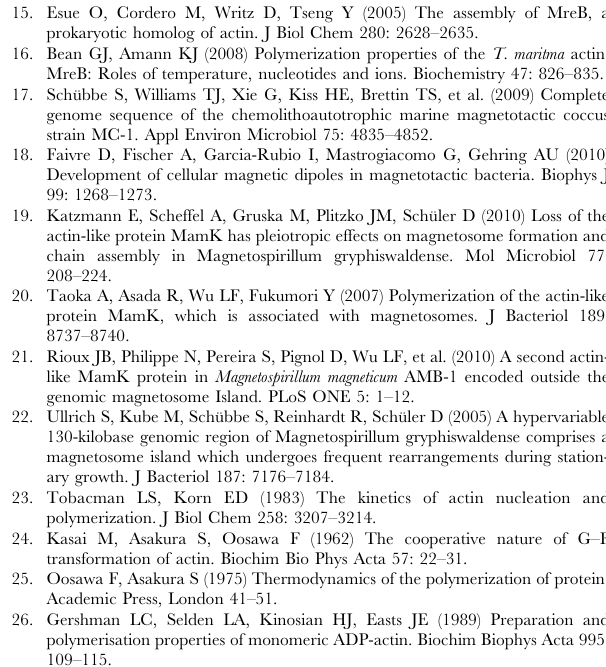
Figure S1 Concentration dependent elution of over- expressed MamK with increasing imidazole. (a) Sodium dodecyl sulfphate-polyacrylamide gel (12%) electrophoresis of purified histidine-tagged MamK eluted using an imidazole gradient to reduce the co-purification of contaminant proteins binding to the column resin. MamK was eluted with increasing concentrations of imidazole in accordance with the procedure described in Protino H -Ni-TED/IDA protocol (Marcherey-Nagel).